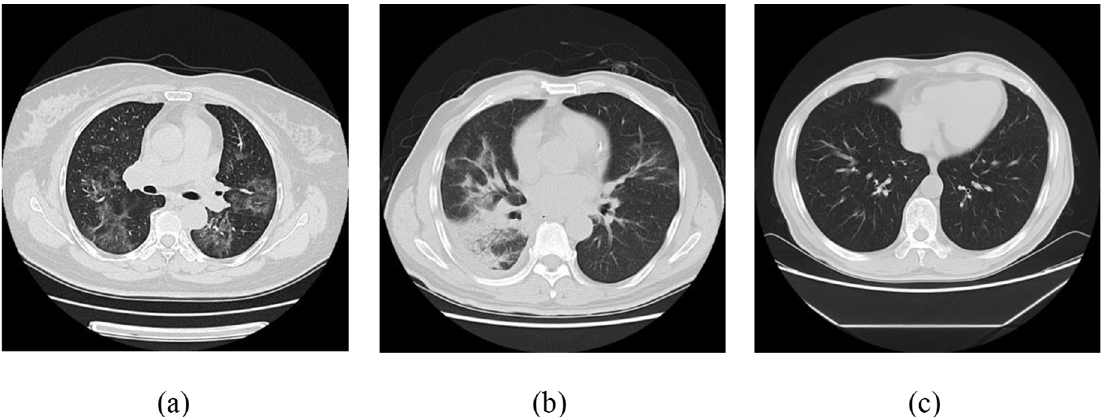
Figure 2. Different sections of the transverse on CT image; ( a ) on the novel coronavirus; ( b ) on influenza A viral pneumonia (IAVP); ( c ) on a healthy candidate who is not infected with the virus.